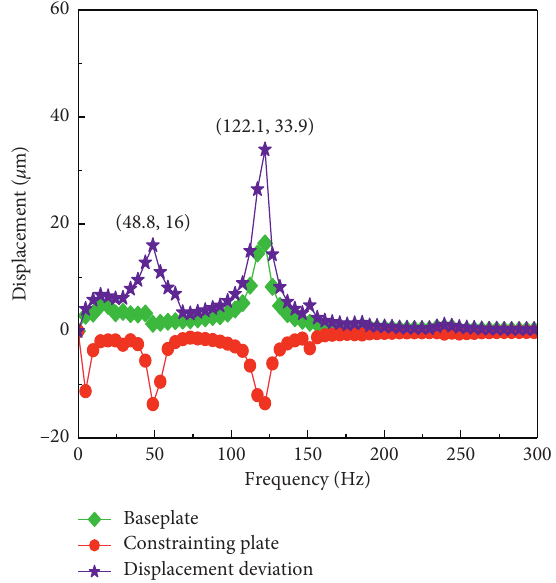
Figure 13: Displacement deviation between the baseplate and the constraining layer (measuring point D1). Table 7: Maximum displacement deviations of the cantilever composite structure with EMWM core at first three order modal